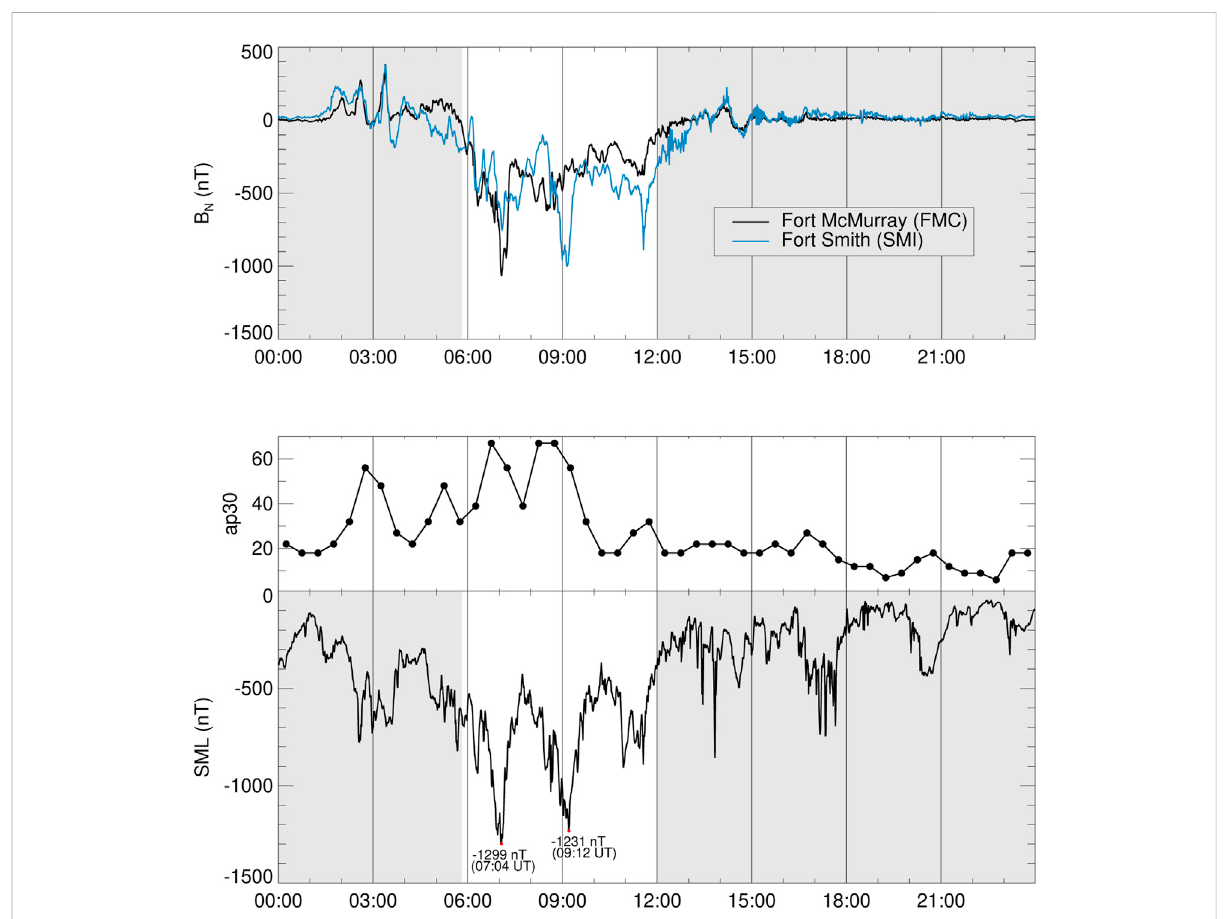
FIGURE 2 Magnetic fi eld disturbances and selectedgeomagnetic indices for 25 October 2019. The top panel shows the magnetic fi eld disturbance in the local magnetic north direction, B N measured by theFortMcMurray (FMC) and FortSmith(SMI) magnetometers.The centre and bottom panels show the ap30 and SML indices